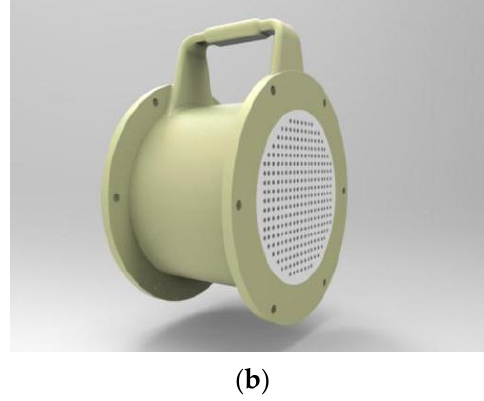
Figure 4. The structure of the porous steady flow plates. ( a ) Two layers of the steady flow plates, ( b ) the installation of the steady flow plates.